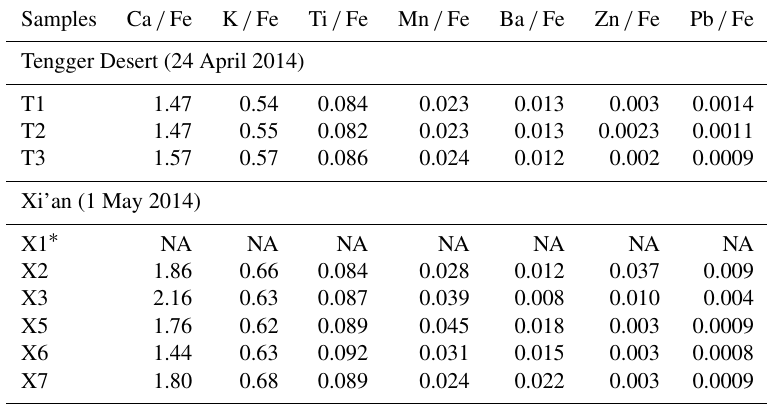
Table 3. Mass ratios of Ca, Fe, Ti, Mn, Ba, Zn and Pb to Fe in the samples at the two sites. Samples Ca / Fe K / Fe Ti / Fe Mn / Fe Ba / Fe Zn /